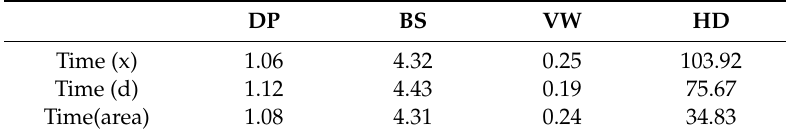
Figure 6. (Color online) Basic geometric units of a part of the British coastline (referring to the red box in the right panel) for each polygon simplification algorithm derived by PolySimp. (Note: Panels on the left show a clear scaling hierarchy of far more small ones than large ones, represented by either dot size or patch color). Table 1. Average running times (in seconds) required to simplify the British coastline at a single level by di ff erent methods using PolySimp. (Note: Configurations of computer used to perform experiments.